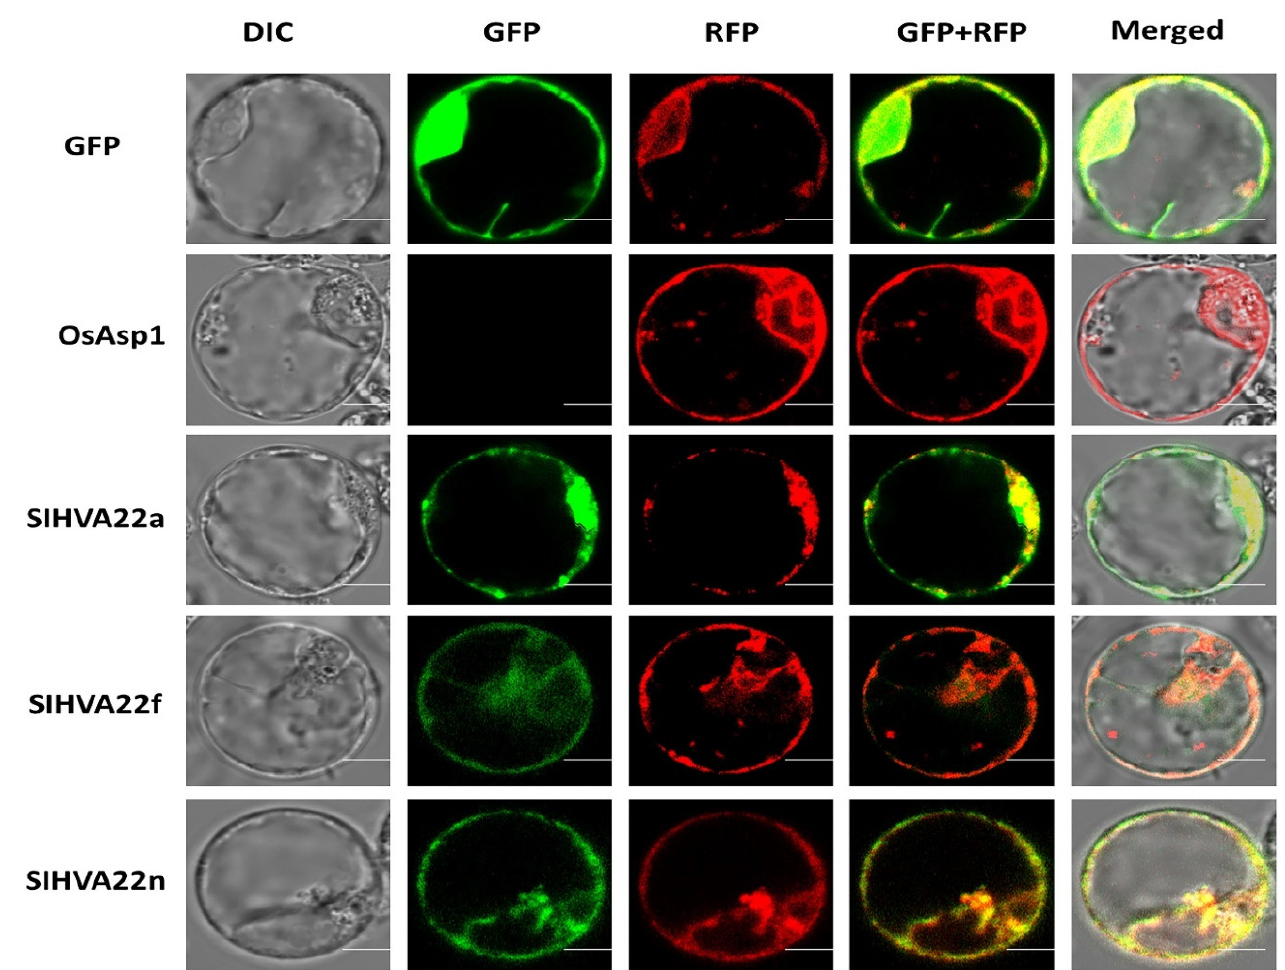
Figure 7. Sub-cellular localization of SlHVA22 proteins. SlHVA22s-SGFP fusion constructs were used to analyze the localization of SlHVA22a, SlHVA22f, and SlHVA22n, and the fluorescence signals were visualized with the confocal microscope. The OsAsp1-mRFP construct was utilized as an ER localization marker. Scale bars = 10 μ m.